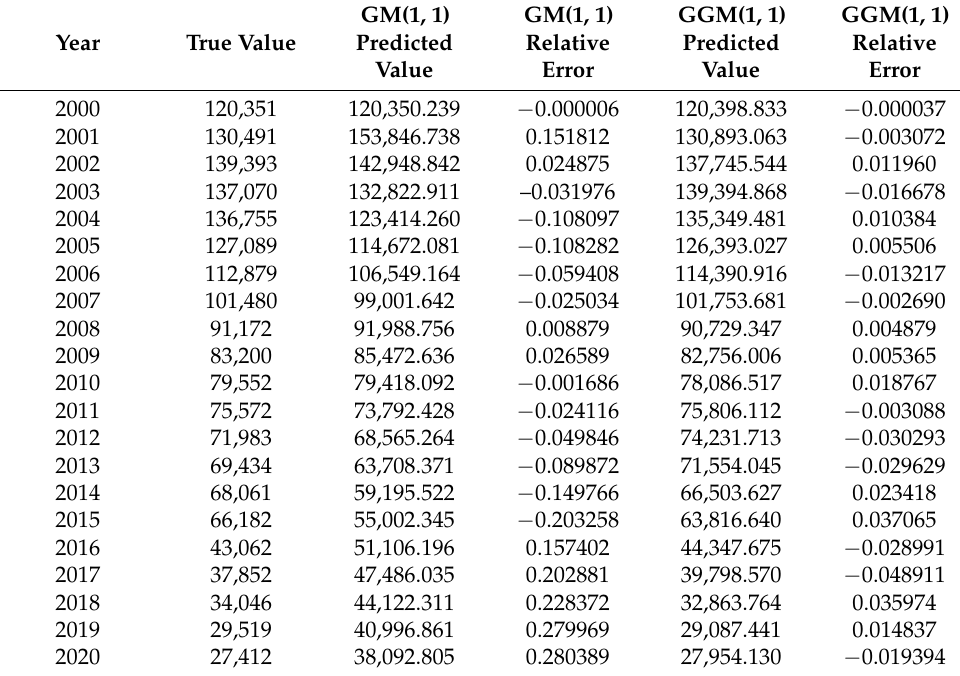
Table 1. Predictive values and errors of accident data by different